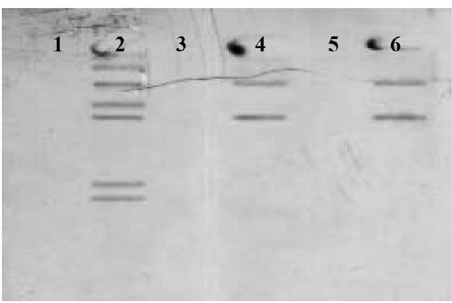
Figure 2. Cry1Ac ligand blot receptors in the lepidopteran Chlosynelacinia isolated from midgut BBMV. For each lane 10 m g of BBMV were used ( N =10 individuals). Lanes: 1. Larval BBMV without binding assay with biotinylated-Cry1Ac (control-group); 2. Larval BBMV binding assay with biotinylated-Cry1Ac; 3. Male butterfly BBMV without binding assay with biotinylated-Cry1Ac (control-group); 4. Male butterfly BBMV with binding assay with biotinylated-Cry1Ac; 5. Female butterfly BBMV without binding assay with biotinylated-Cry1Ac (control-group); and 6. Female butterfly BBMV with binding assay with